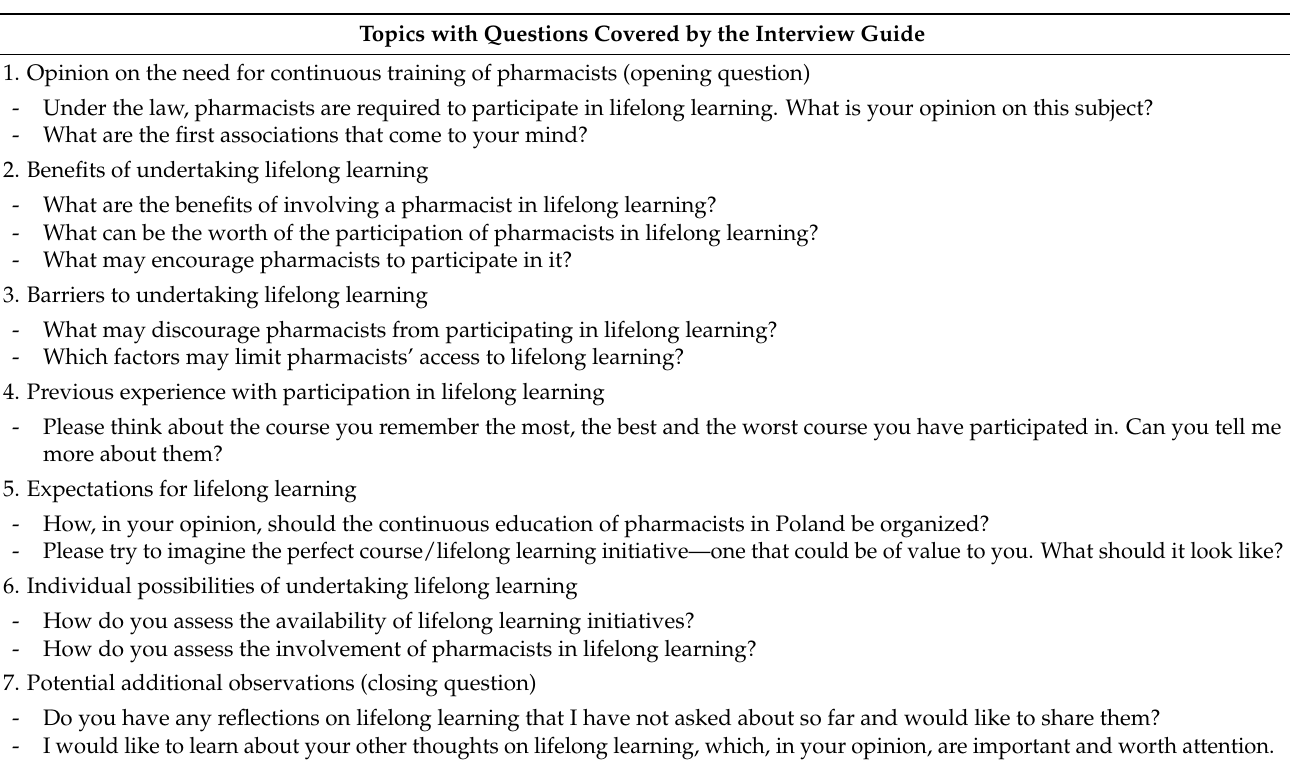
Table 2. The interview guide used during the